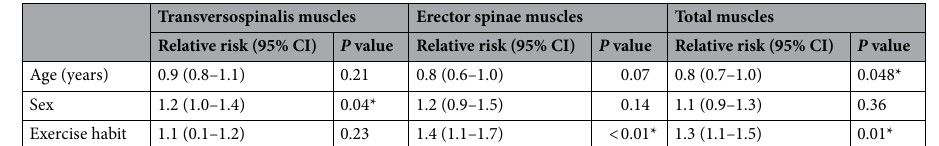
Transversospinalis muscles Erector spinae